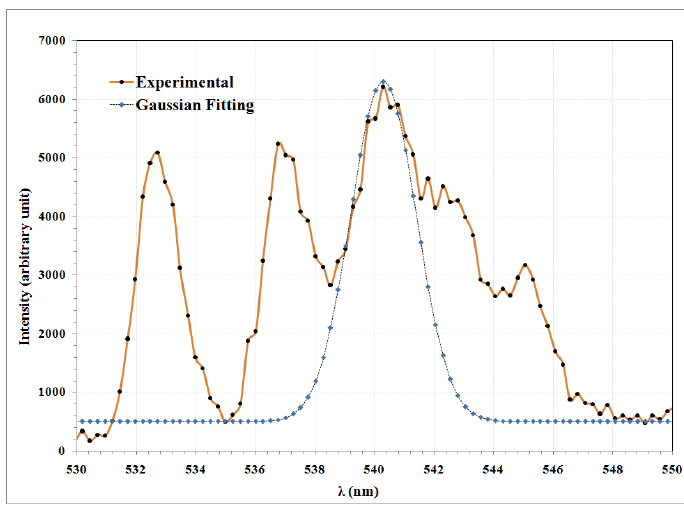
Fig. 8: Fe I peaks at 540.4 nm broadening and there Gaussian fitting.